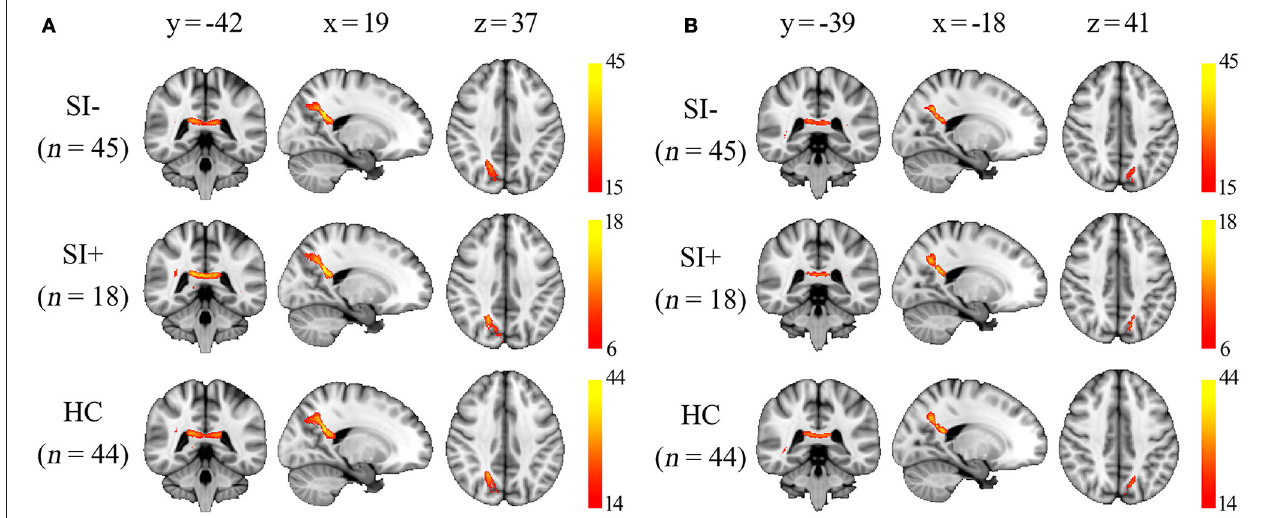
FIGURE 3 | The group probability maps generated from the two regions of interest (ROI) as described in Figure 2B . The maps were thresholded to display the paths presented in at least one-third of subjects in each group, and the color bars represent the proportion of subjects with connection to the ROI in each voxel. (A) Maps generated from the ROI 1 in right posterior corona radiata. (B) Maps generated from the ROI 2 in left posterior corona radiata. x, y, z, MNI coordinates.